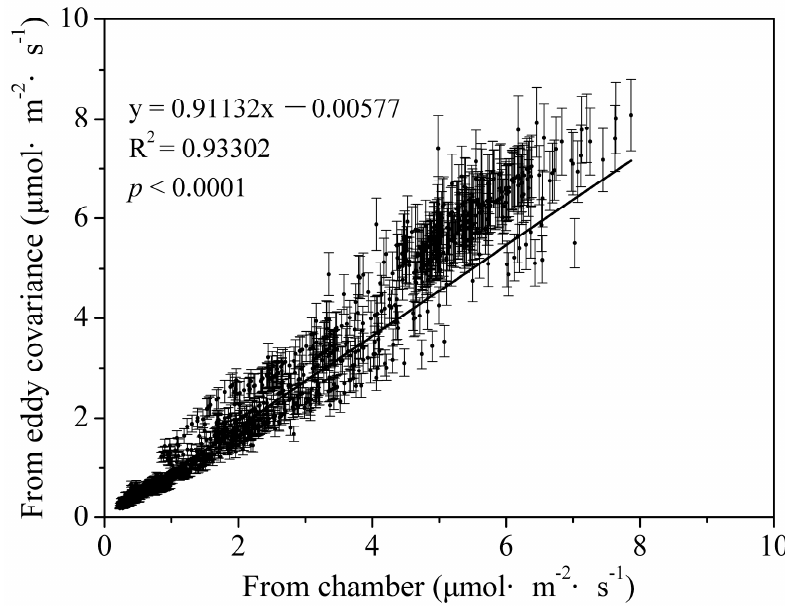
Figure 7. Comparison between chamber-based and eddy covariance measurements of ecosystem respiration. Data are daily mean respiration during 2010–2013. The solid line indicates a linear